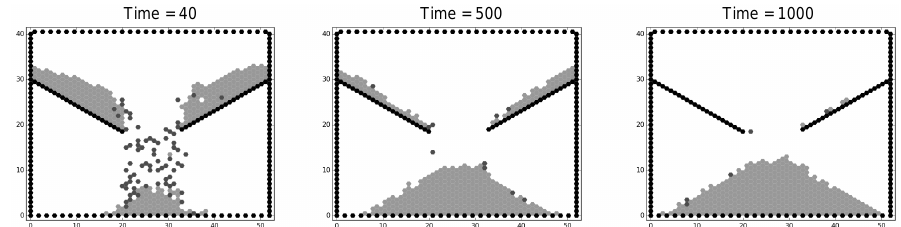
Figure 15. Three snapshots from a lattice-grain simulation showing the emptying of a silo. Color codes: white is empty, black is wall, light gray is resting grain, and dark gray is moving